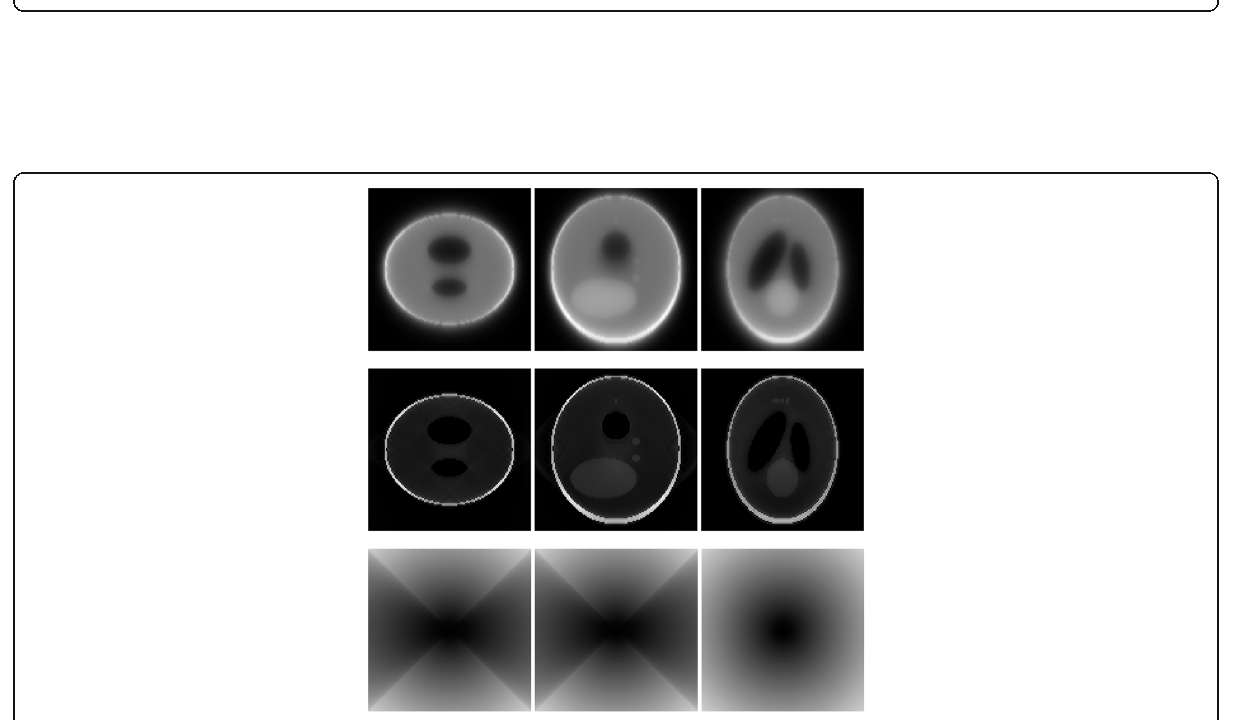
Fig. 6 Image reconstruction using proposed algorithm for the case of ψ = π /4 and σ = 1. Row 1 : TOF backprojection. Row 2 : Final reconstruction. Row 3 : Tomographic filter H . Three central orthogonal cuts are shown for each